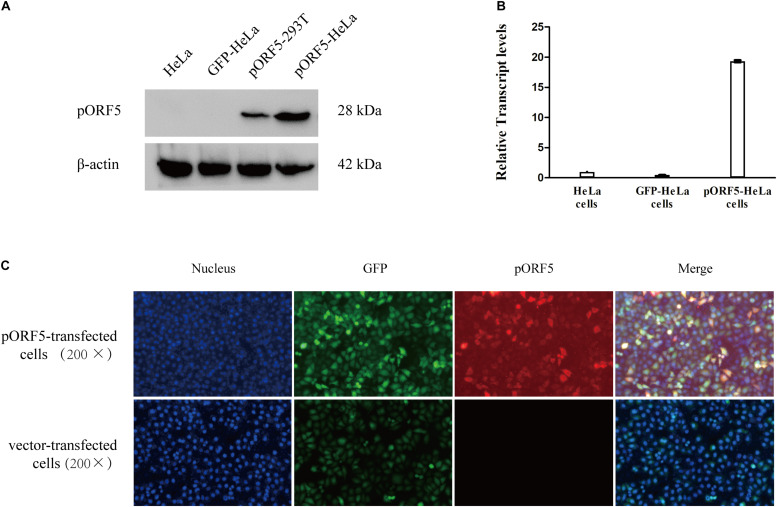
Over-expression of pORF5 in transfected HeLa cells. (A,B) The protein and mRNA expression levels of pORF5 were tested by western blot and qRT-PCR, respectively. (C) The expression of pORF5 detected by IFA. DNA (blue) was stained with Hoechst 33258, GFP (green) was expressed by transfected plasmid. pORF5 (red) was stained with Cy3 (200×).